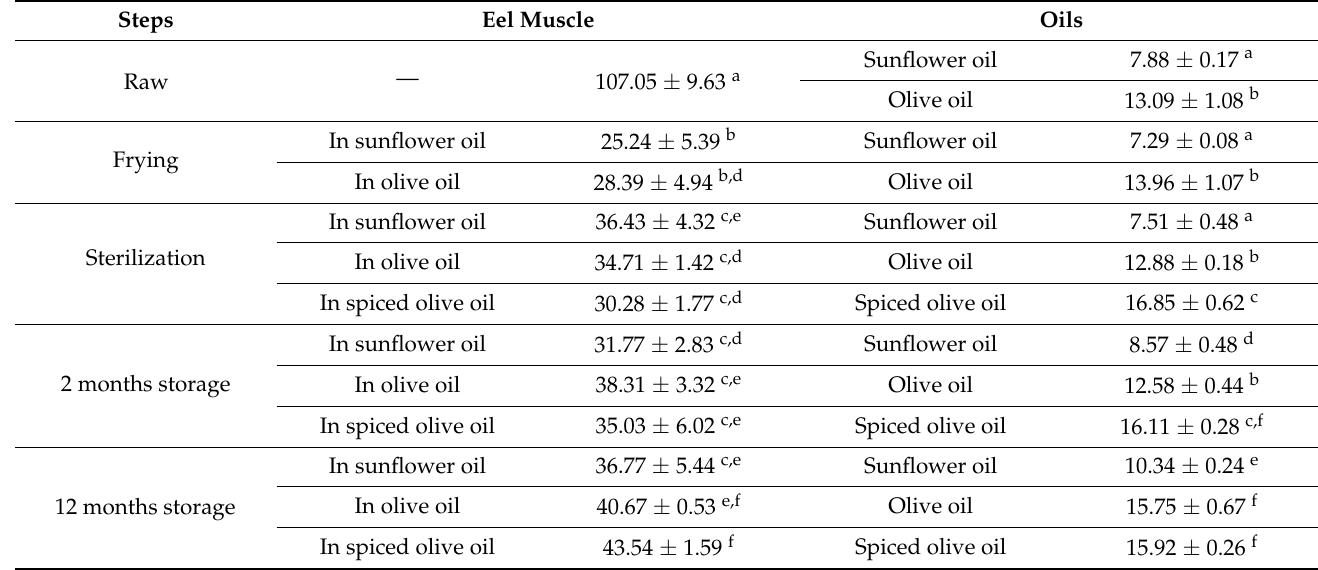
Table 1. The inhibition at 50% (IC 50 ; mg/mL) values of European eel and filling oils after each step during the canning process and after 2 and 12 months of subsequent